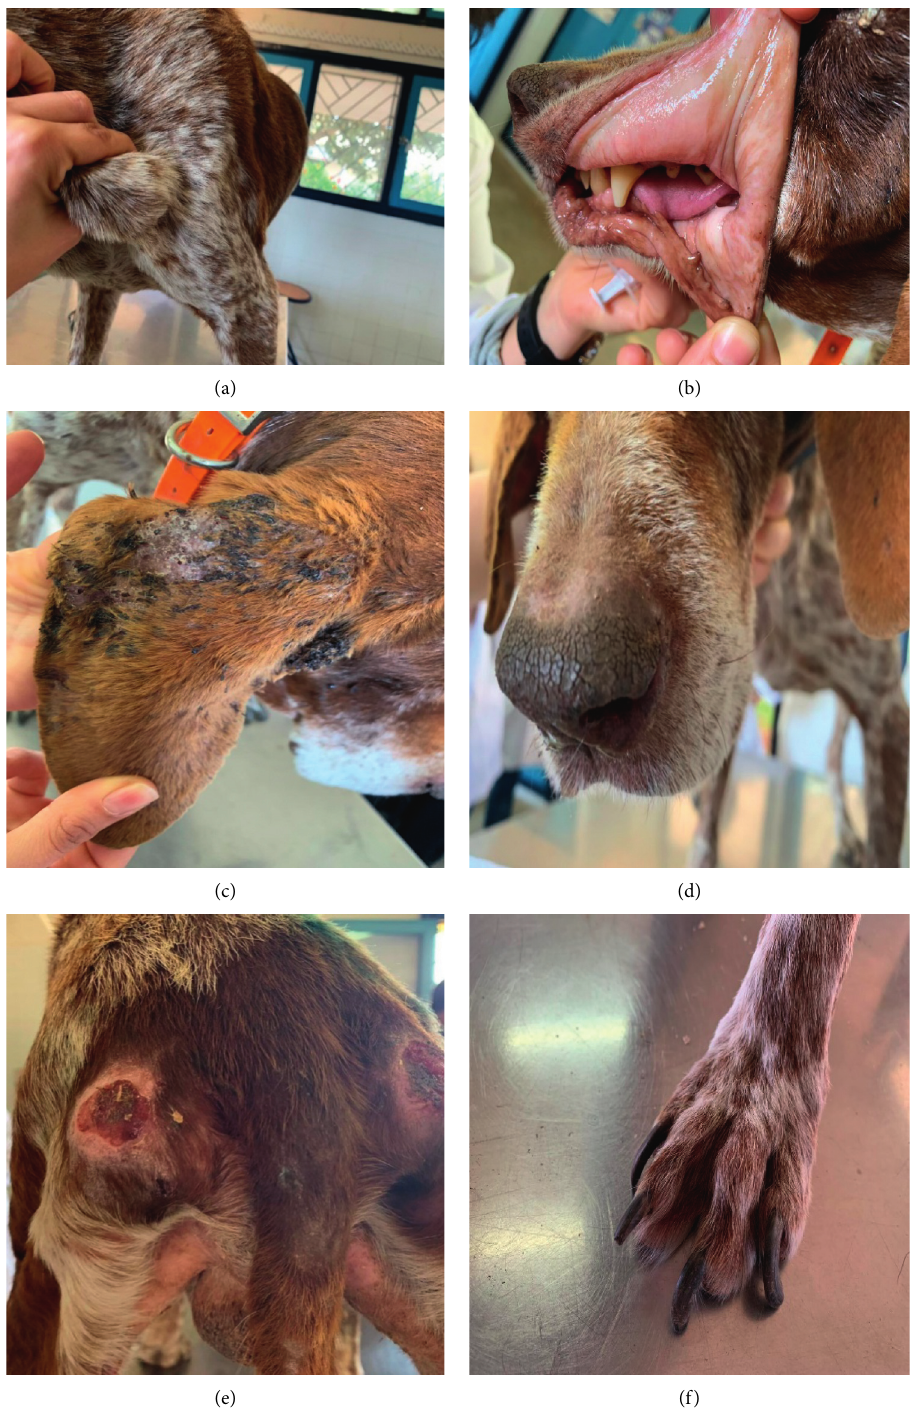
Figure 1: Main clinical signs detected in a Leishmania -positive dog. (a) Hypertrophy of the left prescapular lymph node. (b) Pale gingival mucosa. (c) Exfoliative dermatitis (scales, keratinous debris, and alopecia) localized in the right ear. (d) Nasal hyperkeratosis. (e) Bilateral ulcers in pressure points. (f)